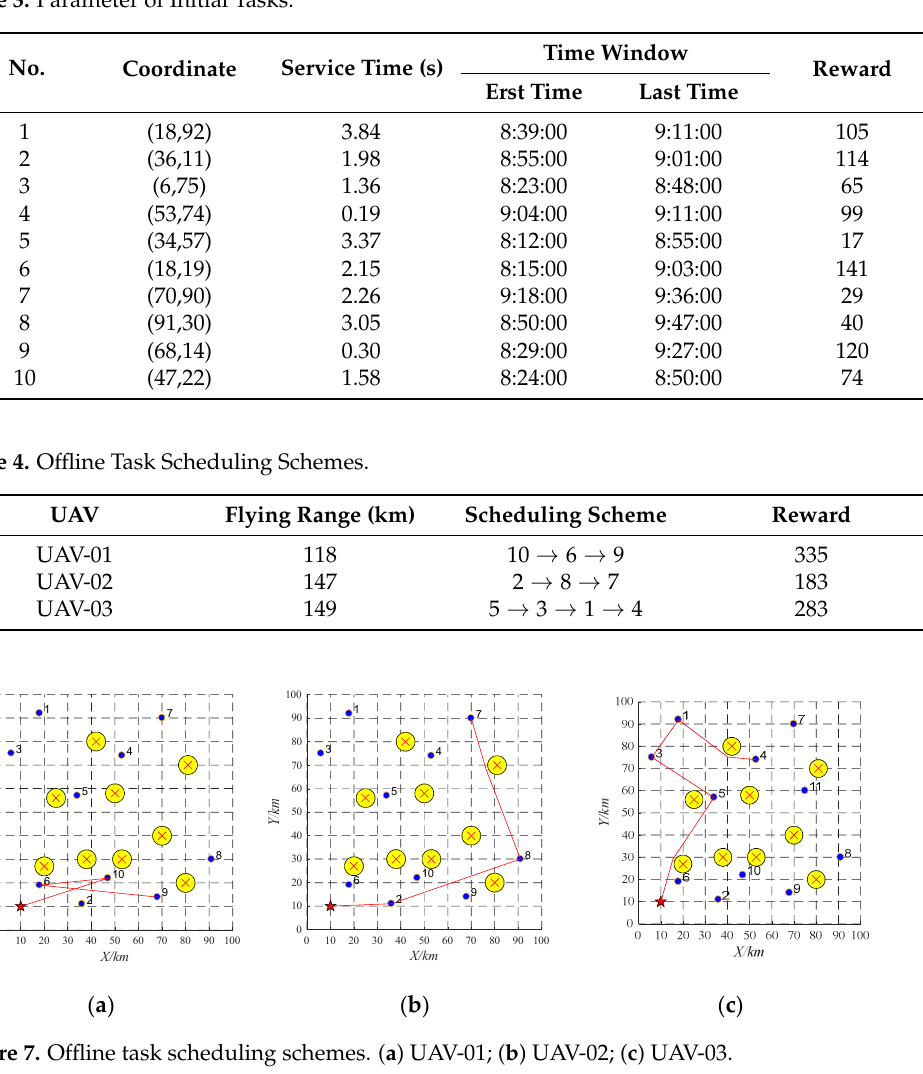
Table 6. Task Re-scheduling Schemes based on Buy-sell Contract to Deal with Emergency Tasks.